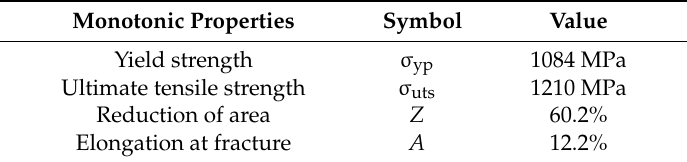
Table 2. Monotonic mechanical properties of 34CrNiMo6 high strength steel.